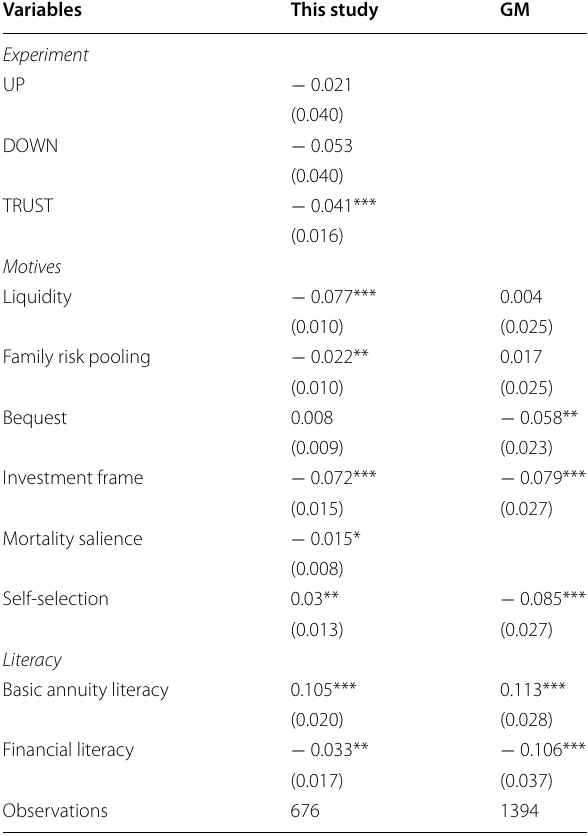
Table 5 Average marginal